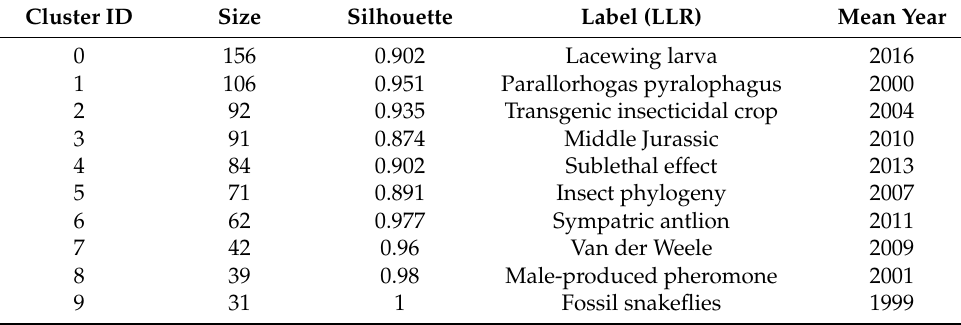
Table 2. Top-ranked clusters about